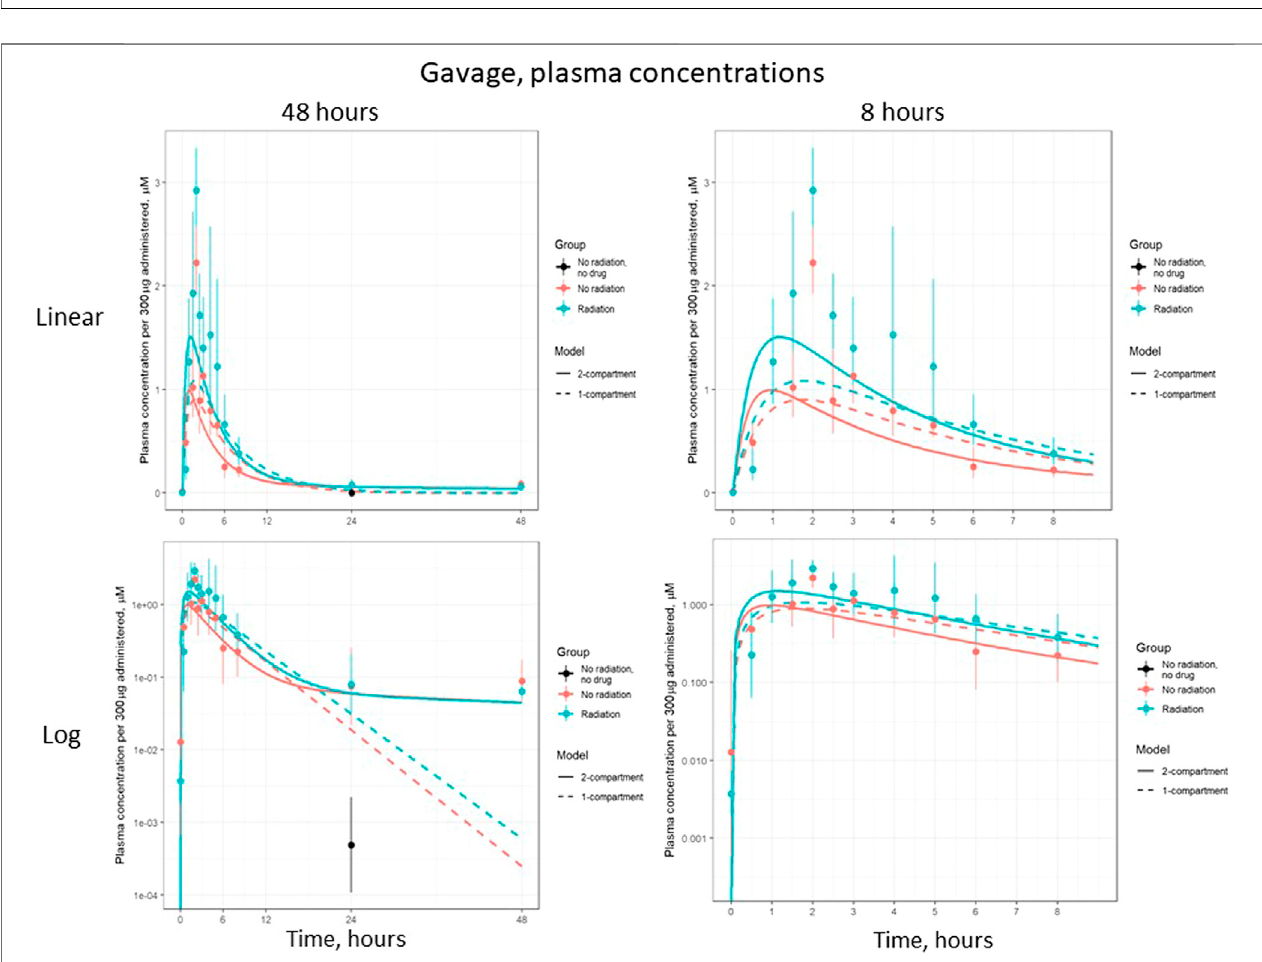
FIGURE 5 | Plasma concentration of lisinopril (geometric mean ± SD) when administered by gavage, broken out by time and scale.